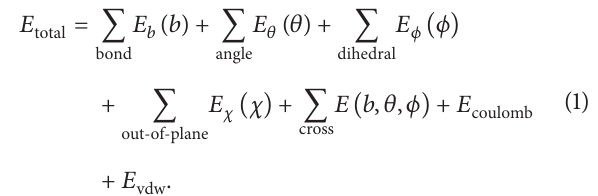
coulomb and van der Waals interaction